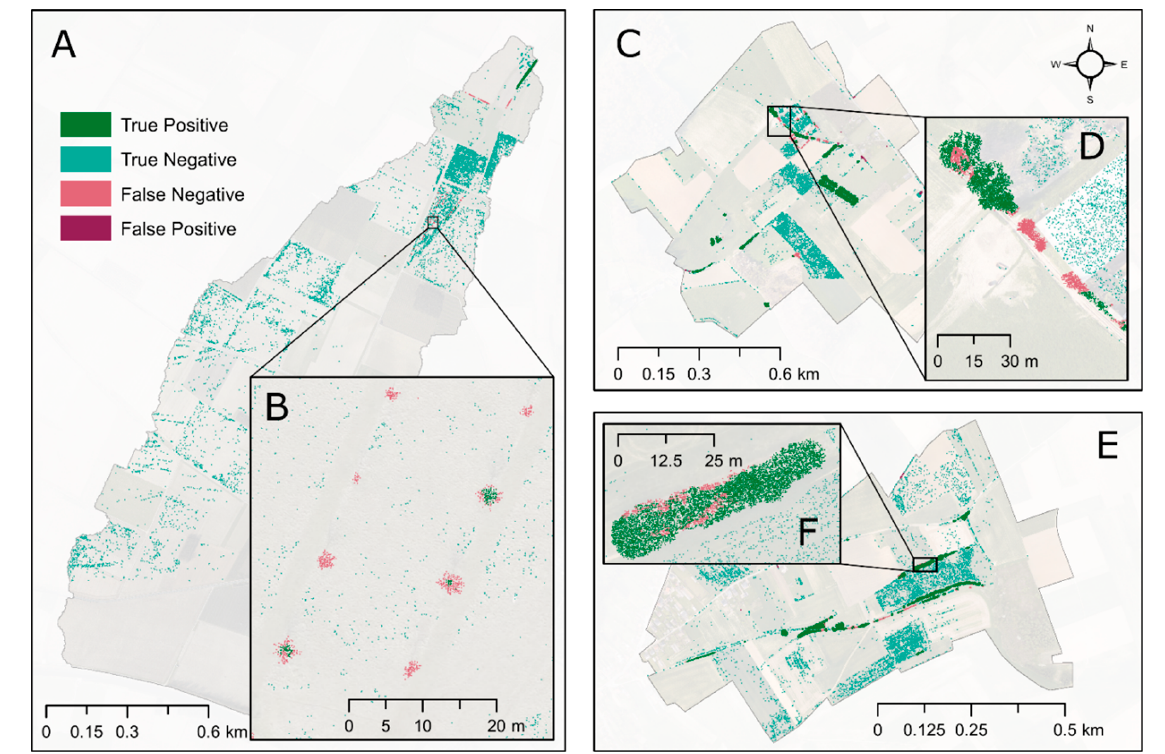
Figure 4. Results of the Random Forest classification of non-ground LiDAR points in SA1 ( A , B ), SA2 ( C , D ), and SA3 ( E , F ). The true positive class (dark green) encompasses the points correctly classified as vLE points. The true negative class (light green) encompasses the points correctly classified as other non-ground points. The false positive class (dark red) encompasses other non-ground points that were falsely classified as vLE points. The false negative class (light red) encompasses other vLE points that were falsely classified as other non-ground points.